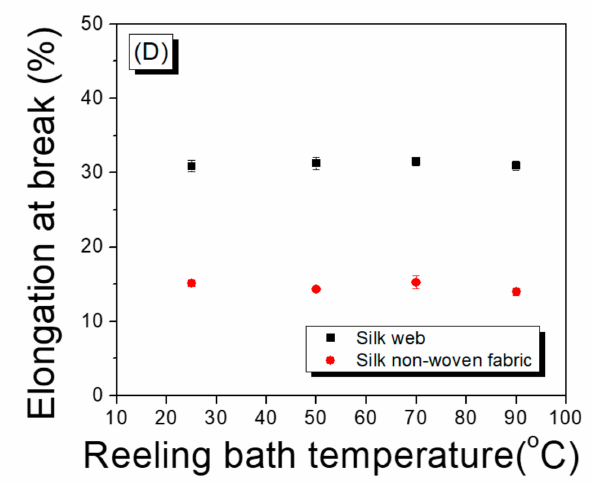
Figure 9. Representative stress–strain curves of the (( A ) silk web and ( B ) silk non-woven fabric), ( C ) tensile strength, and ( D ) elongation at break of the silk web and silk non-woven fabrics prepared at various reeling bath temperatures. The reeling velocity was 39.2